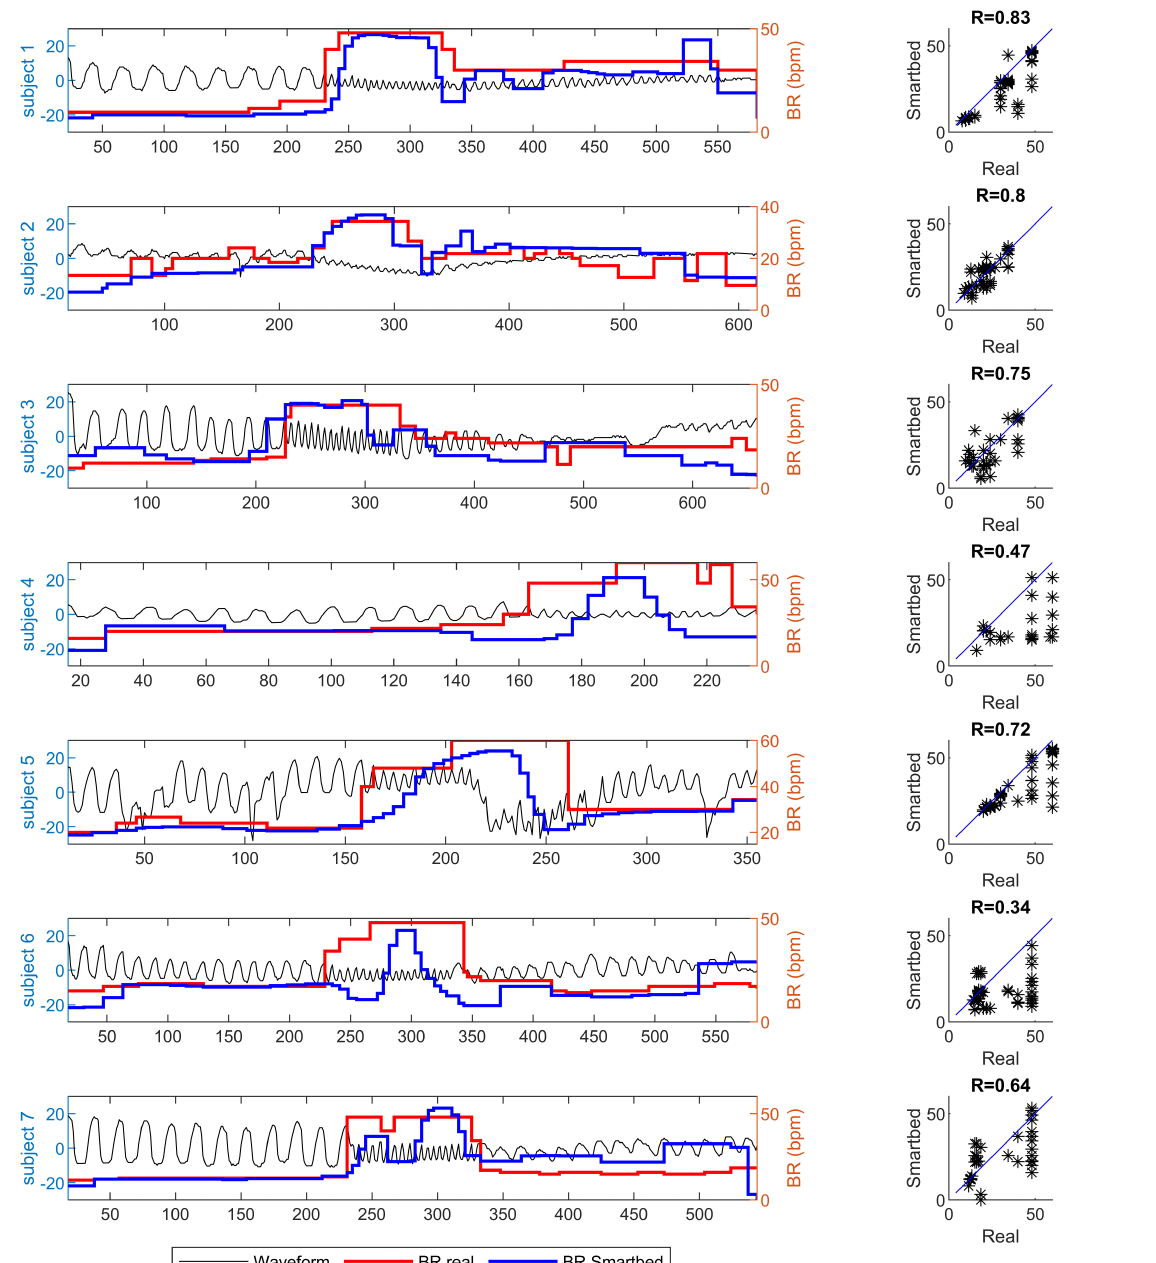
Figure 8. For each subject, the following information are reported: on the left, the waveform (waveform, black line) and estimated breathing rate (BR real, red line) of the reference breathing signal obtained from the sensorized nasal cannula with the estimated breathing rate (BR smart bed, blue line) obtained from smart bed are shown. On the right, the corresponded scatter plots of estimated BR from the smart bed and reference signal are shown together with the diagonal identity lines and Pearson’s coefficient of correlation (R). The units of waveforms are the logical levels of the analog-to-digital converter of an acquisition board used to acquire the reference breathing